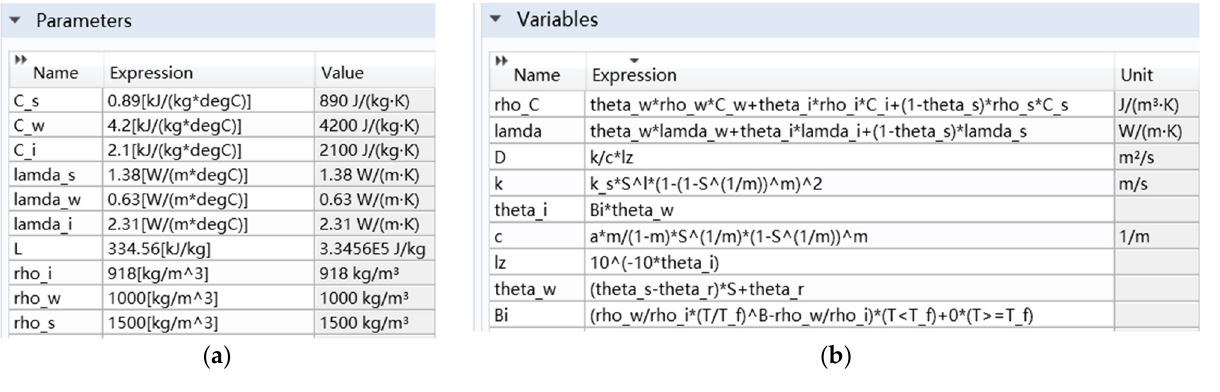
Figure 4. The settings in COMSOL. ( a ) Parameters; ( b ) Variables.